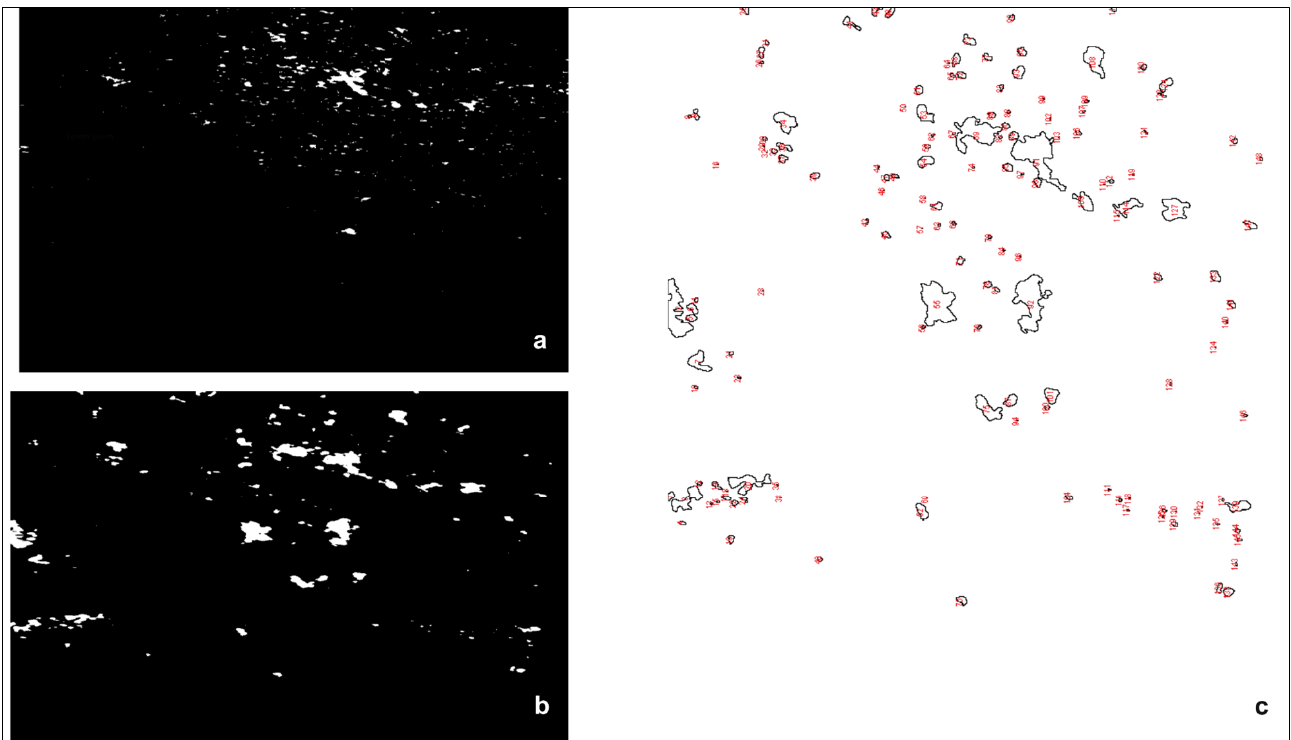
Figure 7. Photomicrographs of thin sections under optical microscope show: ( a ) calculation of porous area under natural condition (i.e., t = 0), ( b ) calculation of porous area under altered condition when the same sample was subject to injection with acid combination (i.e., t = 15 min), ( c ) calculation of the same sample in b after its reaction with the acid combination. The numerical values calculated for the pore area were estimated by ImageJ software.